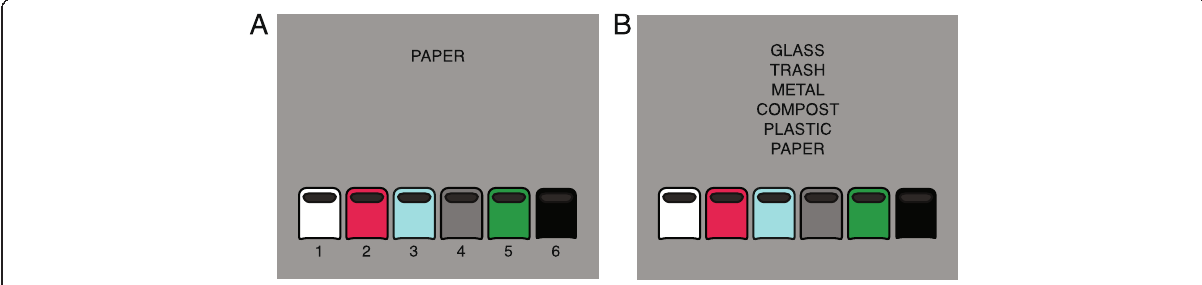
Fig. 9 Example trials in the ( a ) select task and ( b ) match task in Experiment